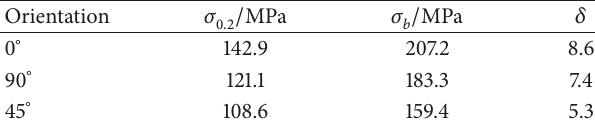
with the simulation result, indicating that the model is applicable to predict the dendrite arm spacing.